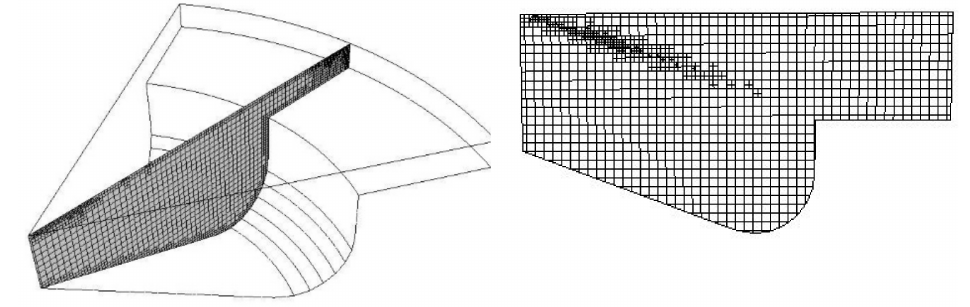
Figure 2. 3D and 2D computational grid of large eddy simulation (LES) using adaptive mesh refinement (AMR) and embedding.